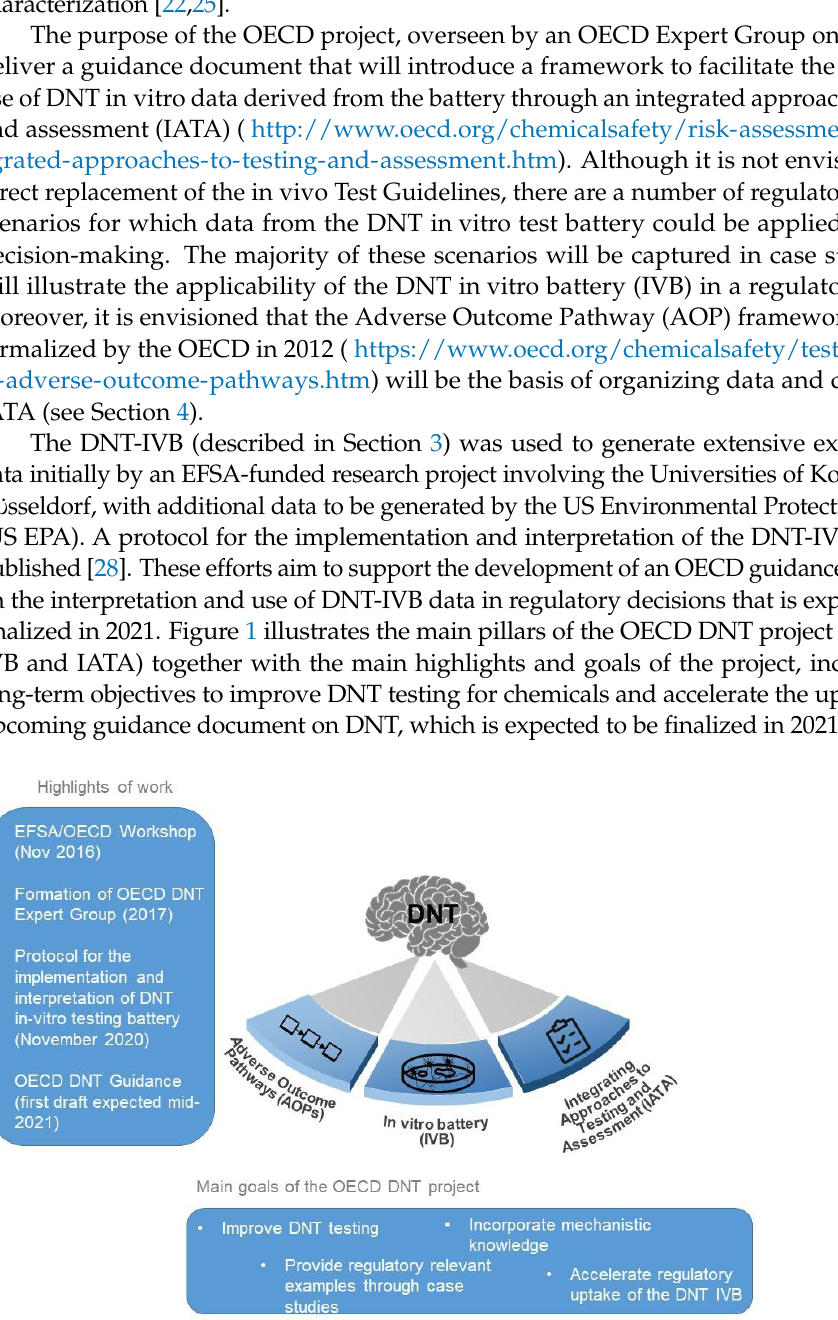
Figure 1. The three pillars of the Organisation for Economic Co-Operation and Development (OECD) developmental neurotoxicity (DNT) project: adverse outcome pathways (AOPs) AOPs, (in vitro battery) IVB, and integrated approaches for testing and assessment (IATA).